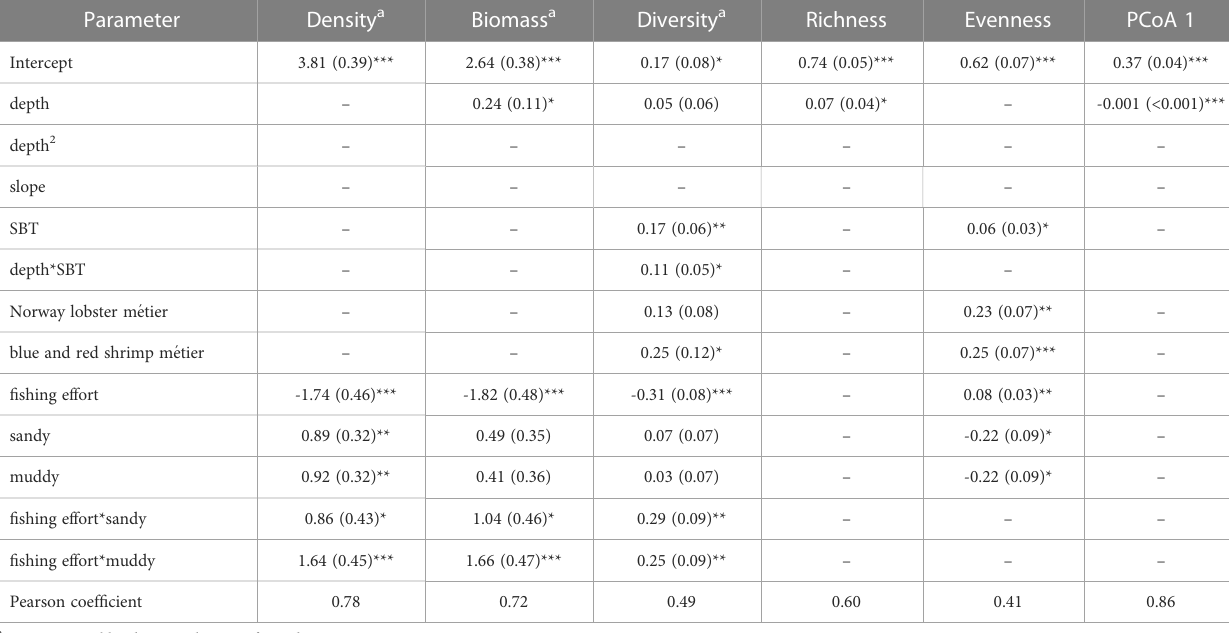
TABLE 3 Results of the generalized mixed effect models (GLMM) of the fi ve community descriptor metrics and the fi rst principal coordinate (PCoA) axis.